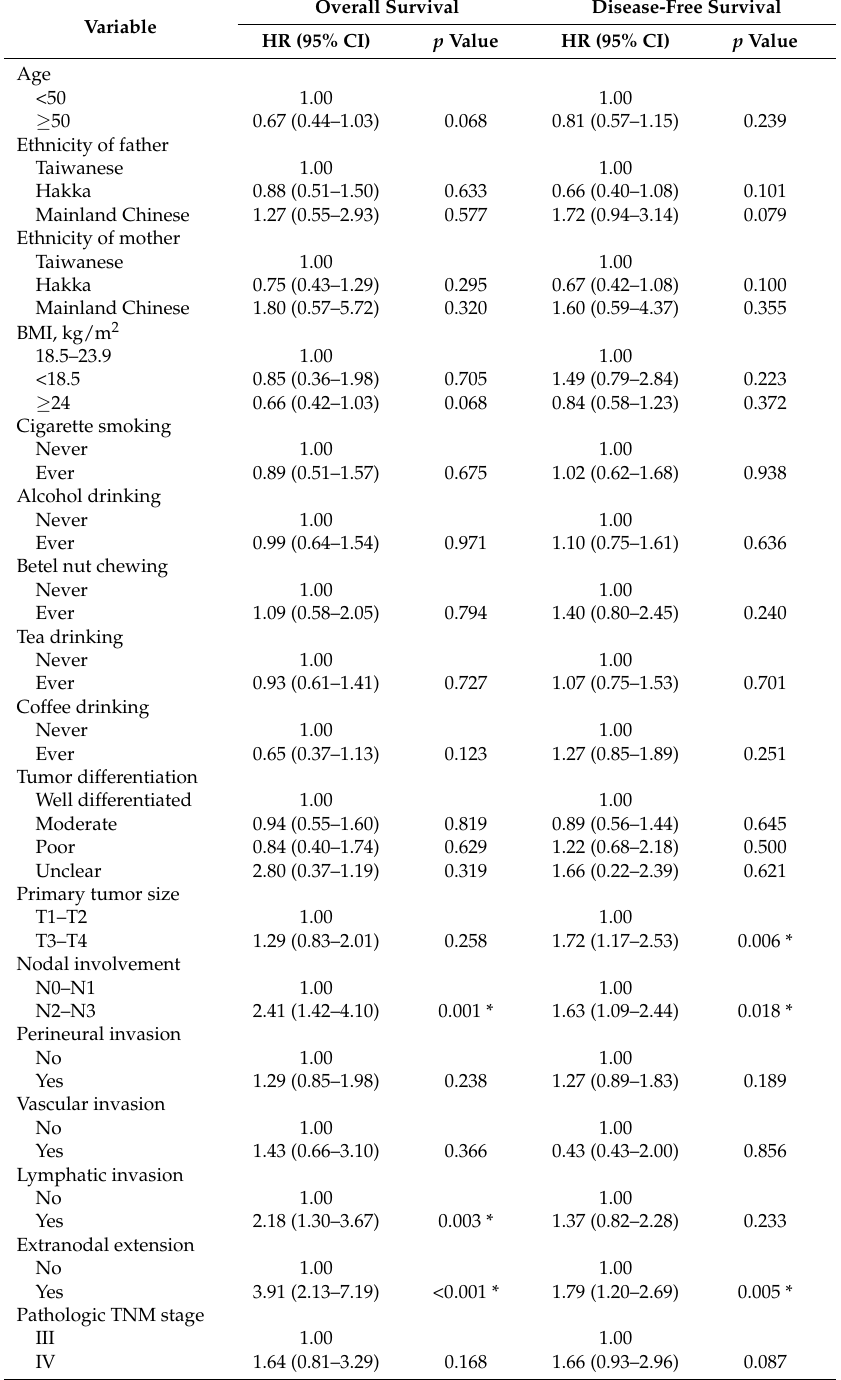
Table 2. Univariate association of demographic and clinical factors with survival in patients with OSCC treated with